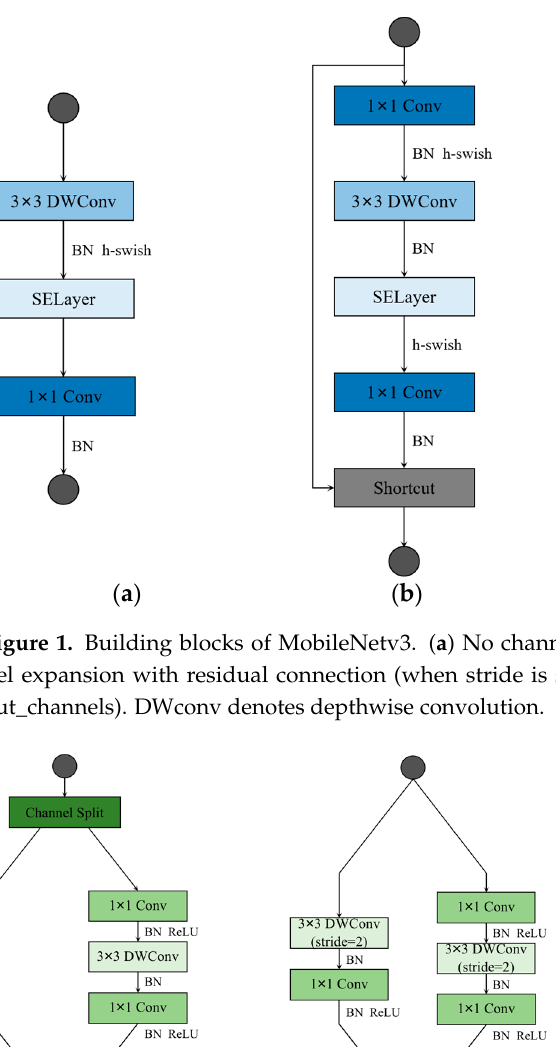
Figure 1. Building blocks of MobileNetv3. ( a ) No channel expansion units; ( b ) the unit of channel expansion with residual connection (when stride is set to one, and in_channels are equal to out_channels). DWconv denotes depthwise convolution.